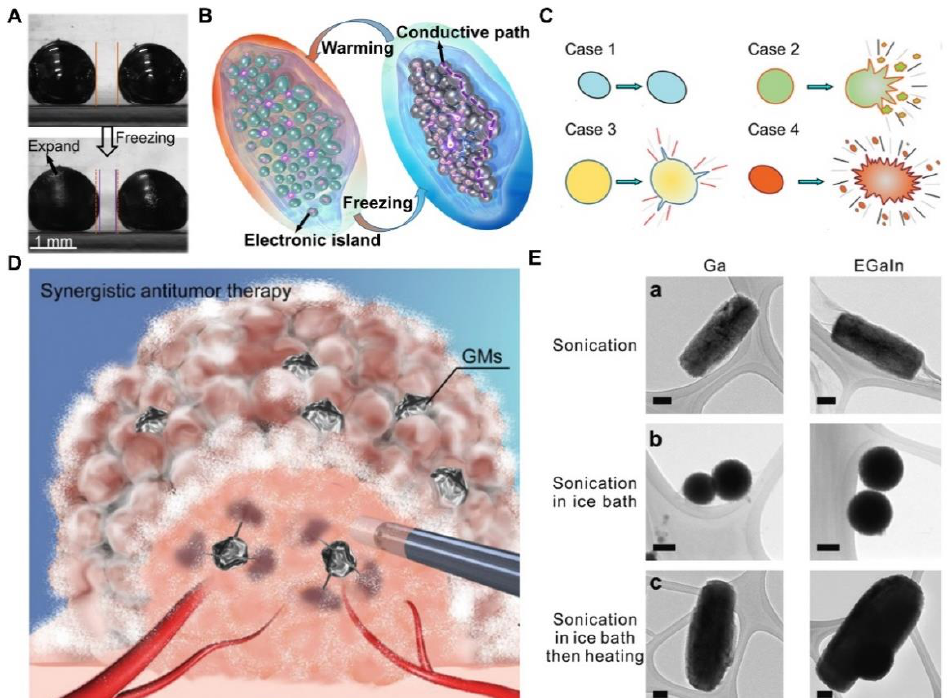
Figure 11. Temperature Induced Response. ( A ) Abnormal expansion of liquid metal (LM) droplets during phase transformation. Reprinted with permission from ref. [113]. Copyright, 2019, The Royal Society of Chemistry. ( B ) Schematic diagram of a functional circuit based on abnormal expansion of LM droplets. Reprinted with permission from ref. [113]. Copyright, 2019, The Royal Society of Chemistry. ( C ) Schematic illustration of four types of transformations of LM droplets induced by temperature. Reprinted with permission from ref. [71]. Copyright, 2020, American Chemical Society. ( D ) Shape change of LM droplets excited by temperature for antitumor therapy. Reprinted with permission from ref. [33]. Copyright, 2020, John Wiley and Sons. ( E ) LM droplets’ response to temperature increase. (a) Rods obtained from sonicating gallium (left column) and EGaIn (right column) in aqueous solution in the presence of Lys protein; (b) Nanospheres synthesized by repeating (a) While using an ice bath; (c) Rods obtained from post heating the spheres from (b); Here, the scale bars are 100 nm. Reprinted with permission from ref. [150] . Copyright, 2019, The Royal Society of Chemistry.